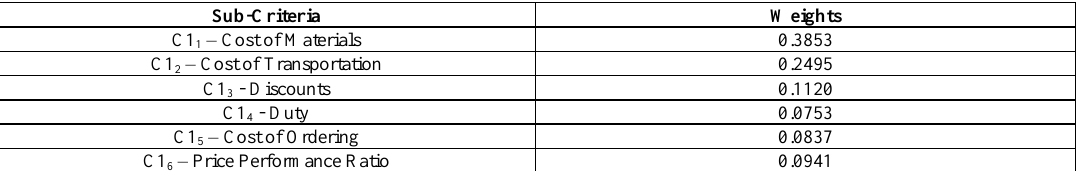
Table 3. Weights of sub-criteria within economic cluster.